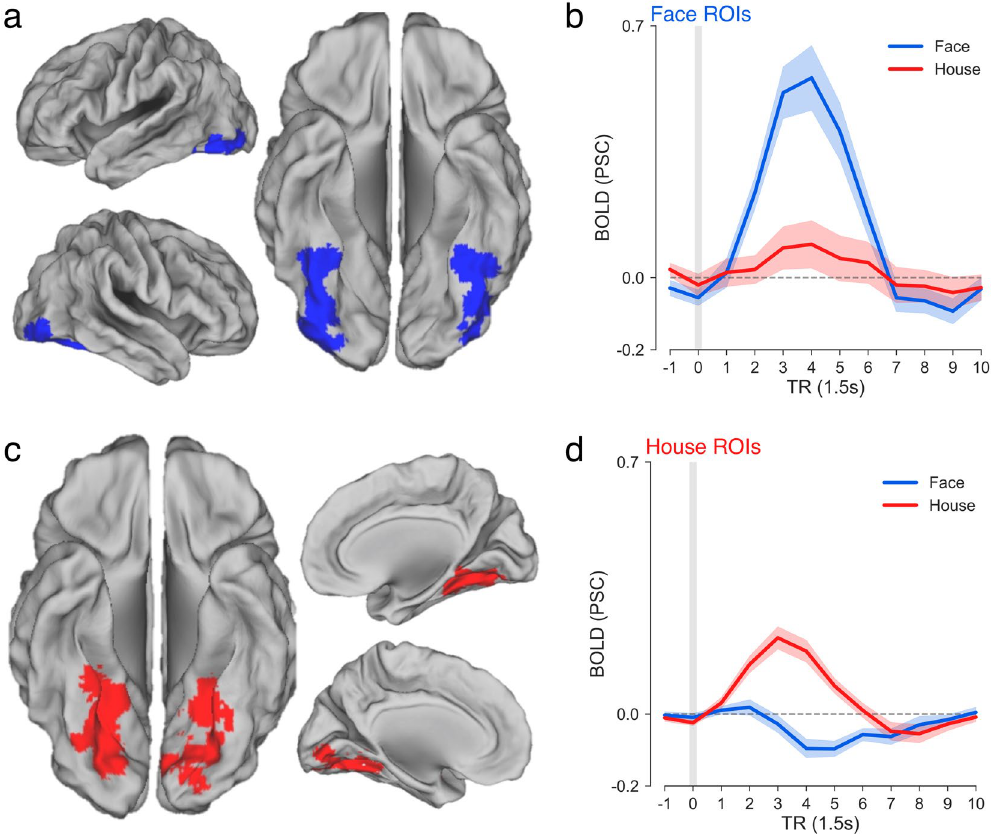
Figure 3. Category-selective regions and activity in ITC. ( a ) Face-selective ROIs, shown as a single contiguous cluster including all individual subject-localized face ROIs (N = 19). The average face-selective ROI across subjects was 349.73 voxels (SEM = 59.02). ( b ) Average timecourse of stimulus-evoked activity in face ROIs on correct face (blue) and house (red) trials. ( c ) House-selective ROIs (M = 364.32 voxels, SEM = 68.29) and ( d ) stimulus activation timecourses in house ROIs with same plotting conventions as in ( b ). Surface mapping was performed with Caret 45 and the SuMS database 46 . Shaded area reflects + / − 1